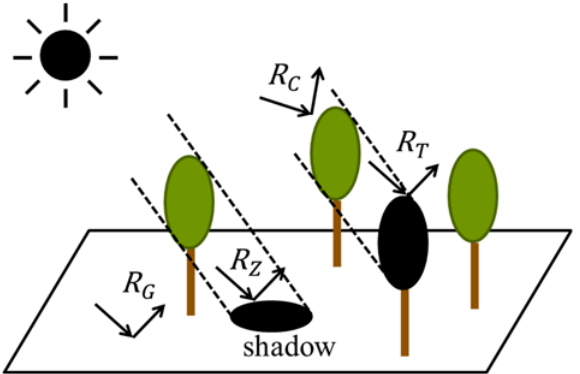
Figure 2. Modeling of shadow effects on geometric